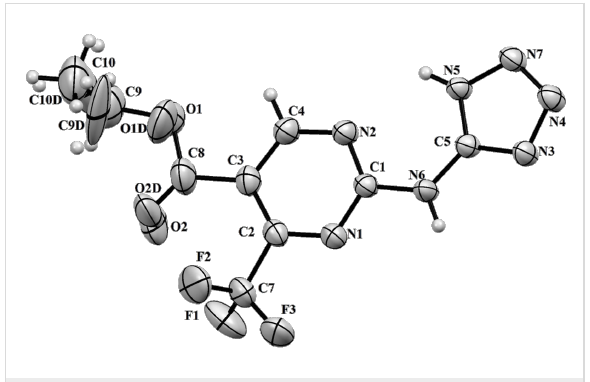
Figure 1: X-ray crystal structure of compound 5 (ORTEP drawing, 50% probability